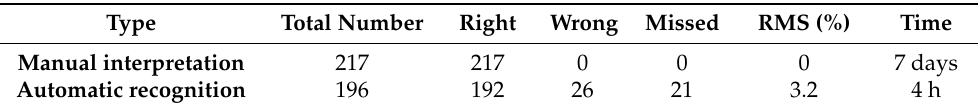
Table 3. Comparison between automatic recognition and manual reading for structural planes in the borehole